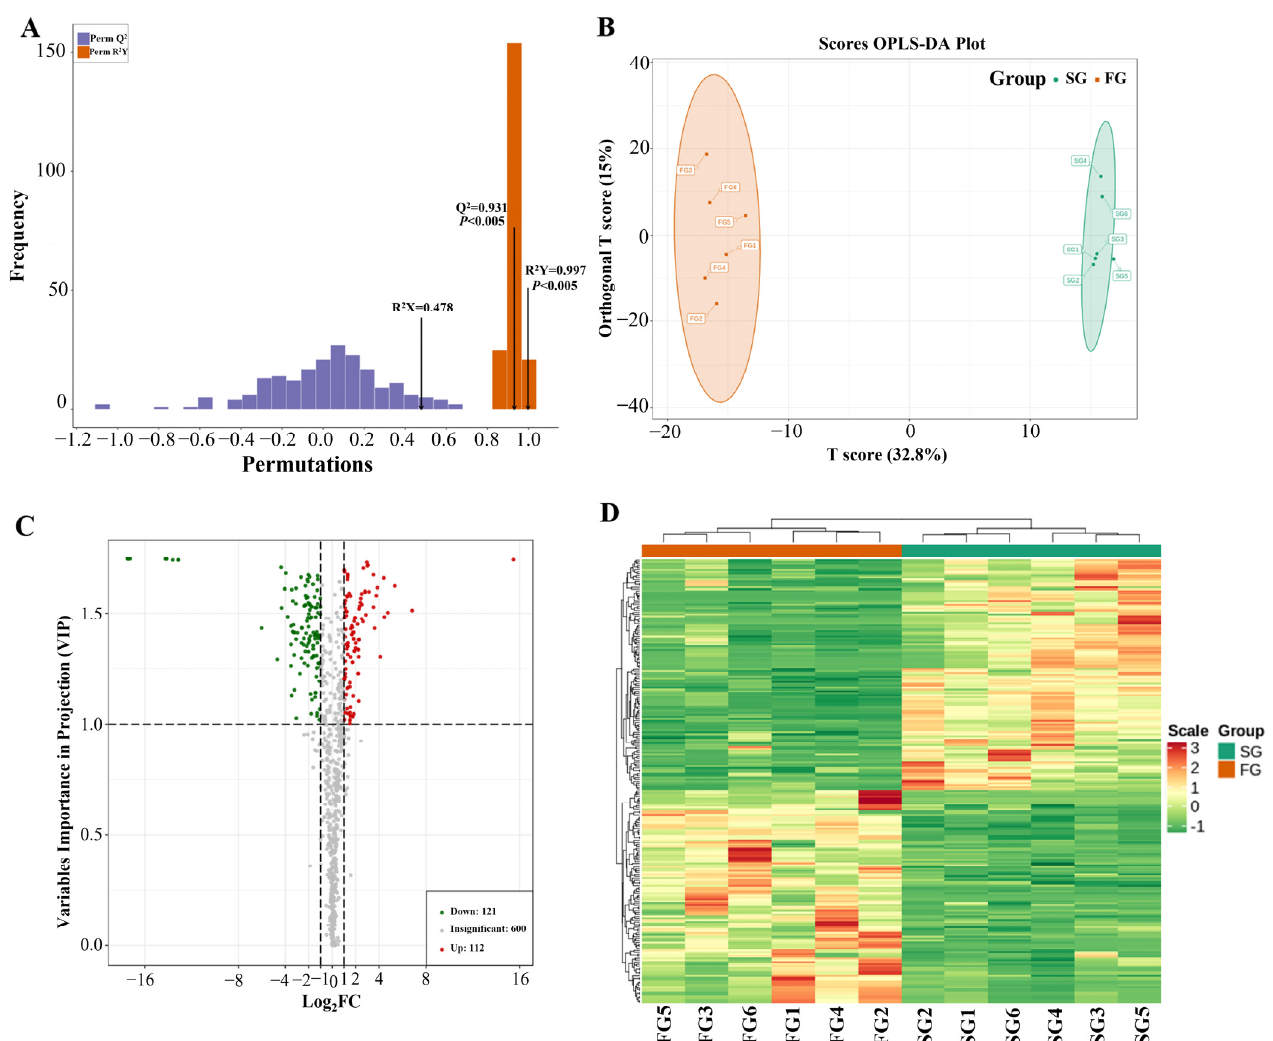
Figure 3. Identification of differential metabolites between slow-growing and fast-growing (SG and FG) meat. ( A ) Model validation of supervised multiple regression orthogonal partial least-squares discriminant analysis (OPLS-DA) pairwise comparisons. ( B ) The score plots of OPLS-DA pairwise comparisons. ( C ) Volcano plots of differential metabolites. ( D ) Hierarchical clustering analysis (HCA) of the metabolites.